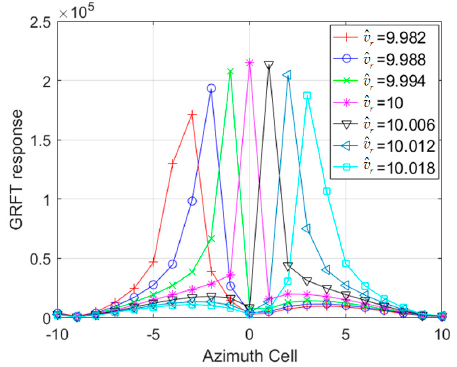
Figure 5. Azimuth profile of GRFT responses to radial velocity’s fine searching.